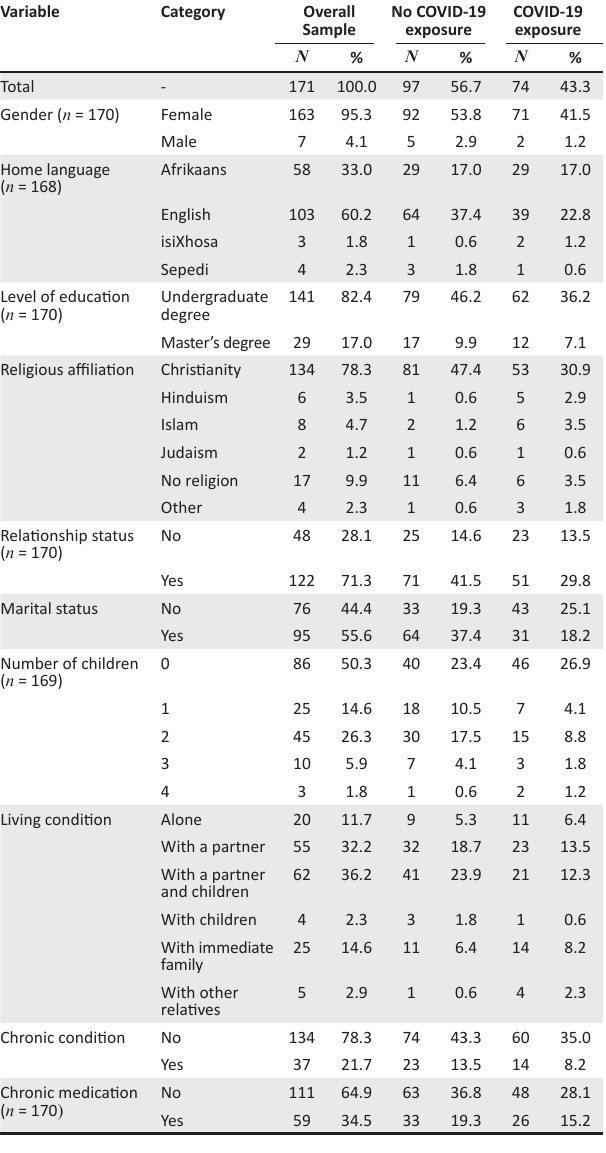
TABLE 1: Demographic characteristics of the sample: Overall and by group. Variable Category Overall